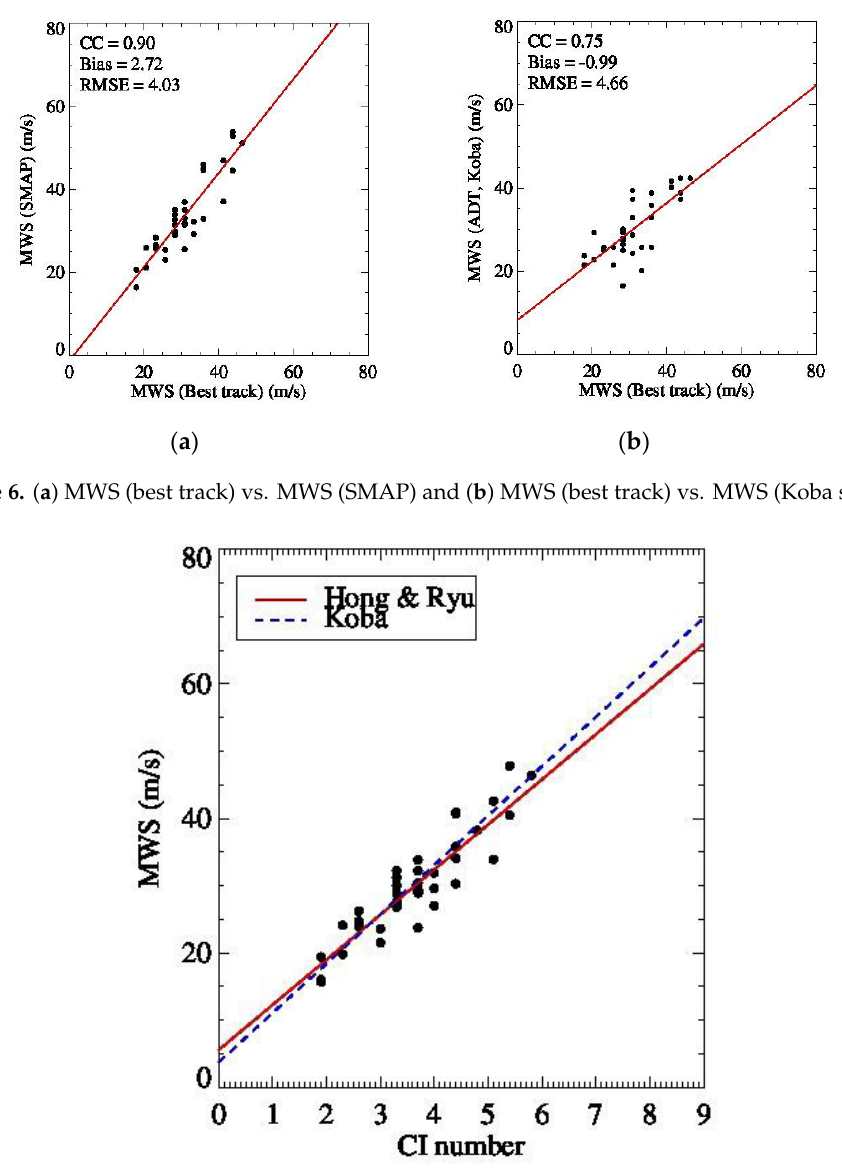
Figure 7. Koba (blue dotted line) and Hong and Ryu (red line) scales depending on the CI number. Table 3. Conversion table for Koba and the computed Hong and Ryu scales.